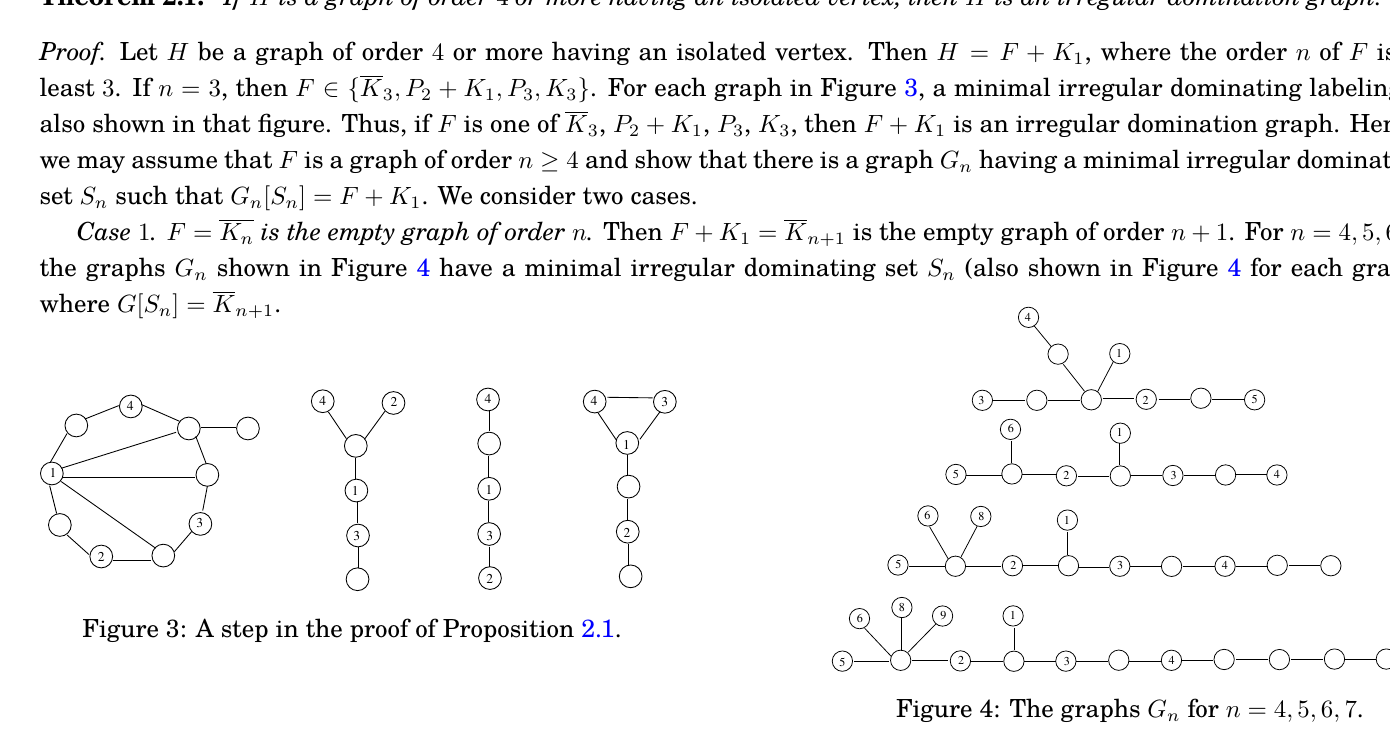
Figure 4: The graphs G